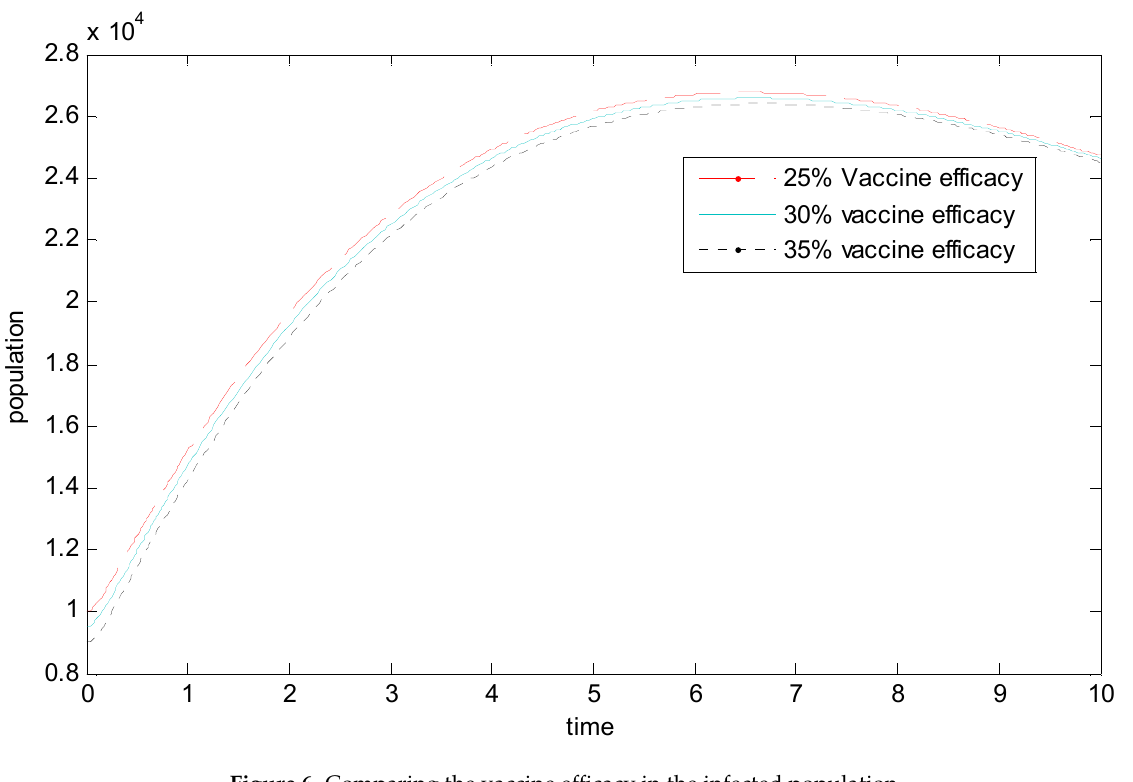
Figure 6. Comparing the vaccine efficacy in the infected population. Figure 7 shows the influence of the variation in the fractional-order α on the biological be- havior of the infected population. It is clear from this figure that the population has a decreasing effect when α is decreased from 0.2 to 1. Hence, the memory effect can be clearly seen.